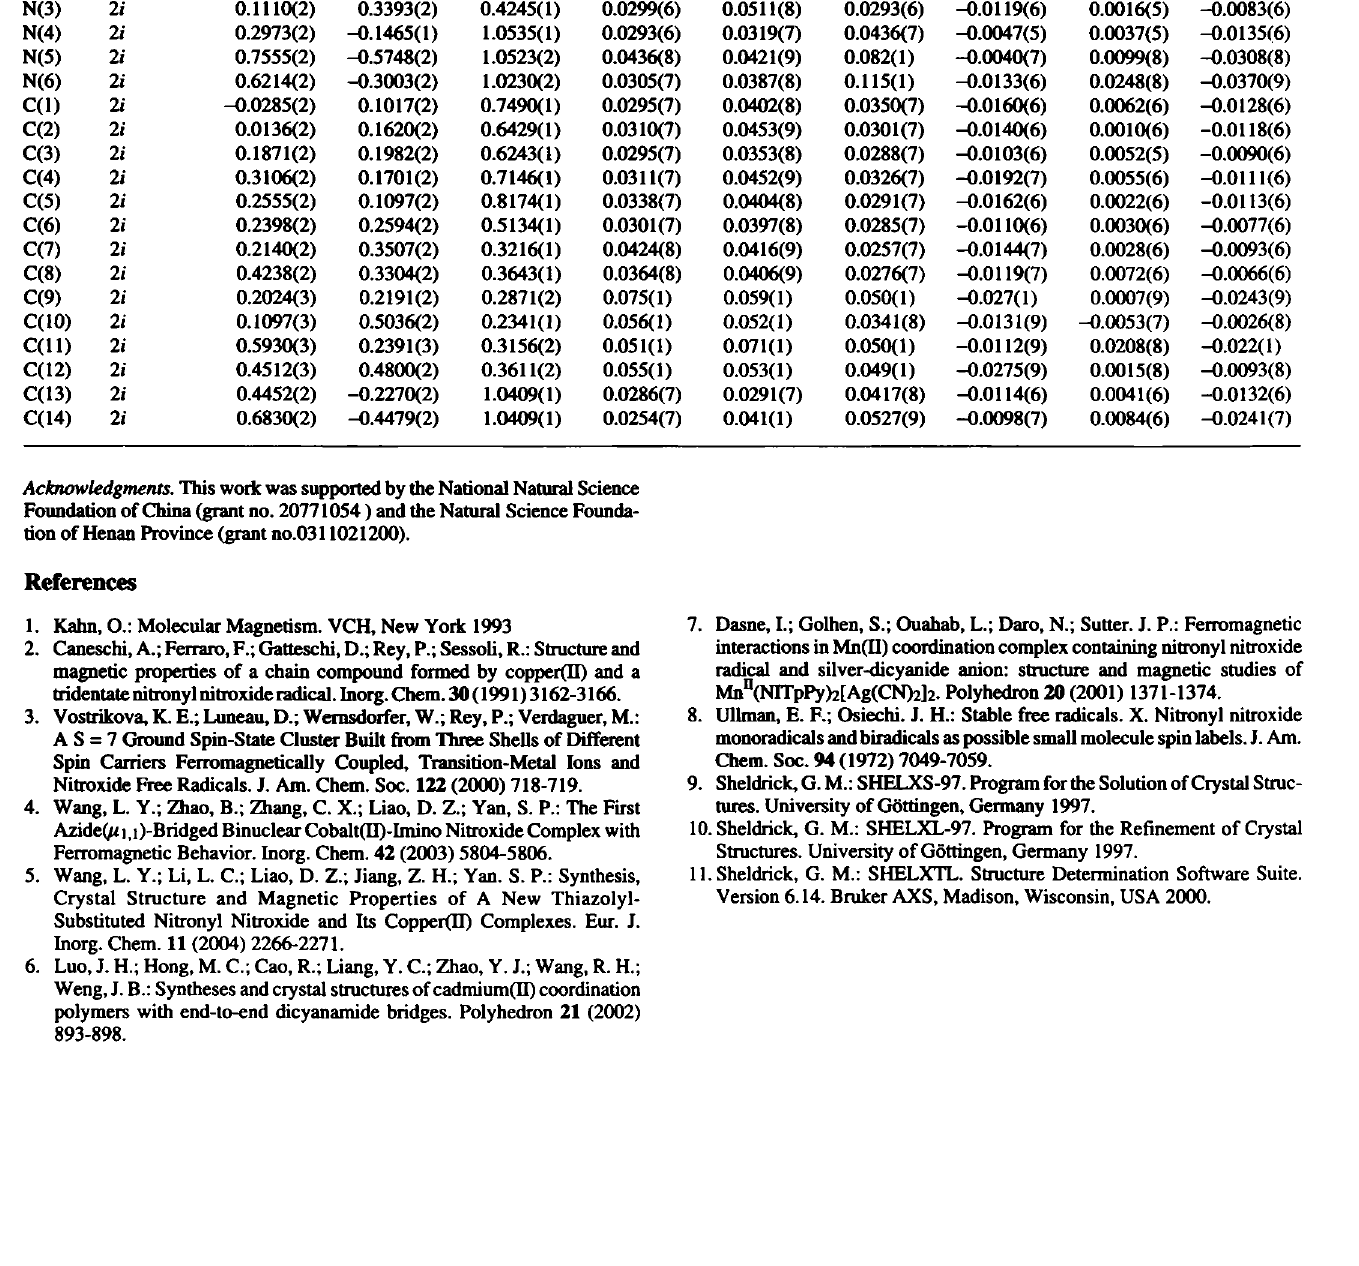
Table 3. Atomic coordinates and displacement parameters (in Â 2